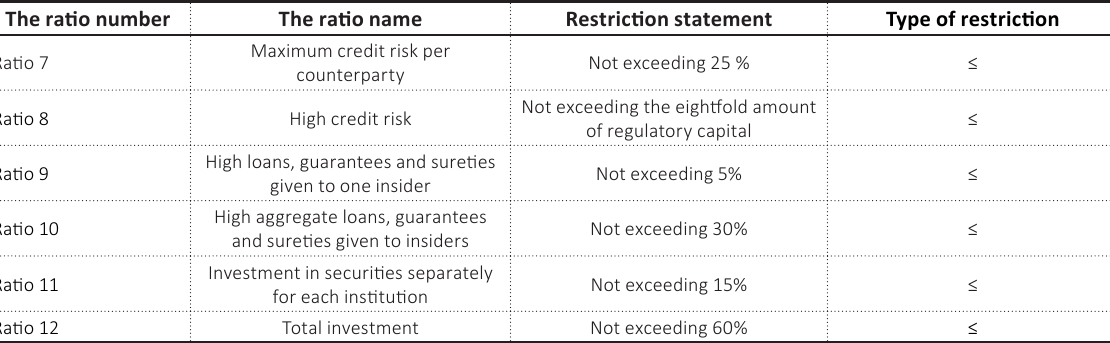
Table 2. Economic standards for operational control over financial stability of banking activities that are unilaterally limited under the “not exceeding” term or